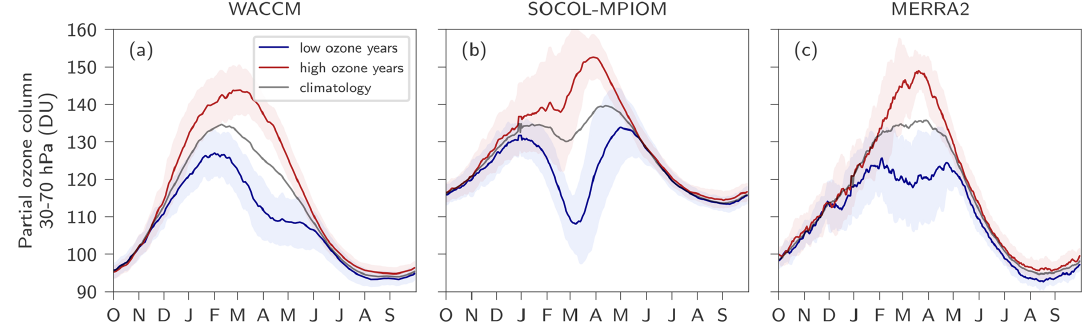
Figure A2. Ozone evolution in high- and low-ozone years. Evolution of ozone over the year in the 25% of years with the lowest (blue) and highest (red) springtime partial ozone column values between 30 and 70hPa in (a) WACCM INT-3D, (b) SOCOL-MPIOM INT-3D, and (c) MERRA2. The grey line shows the climatology over all years in the respective datasets (200 years for WACCM and SOCOL-MPIOM and 41 years for MERRA2). Shaded areas show the standard deviation across high- and low-ozone